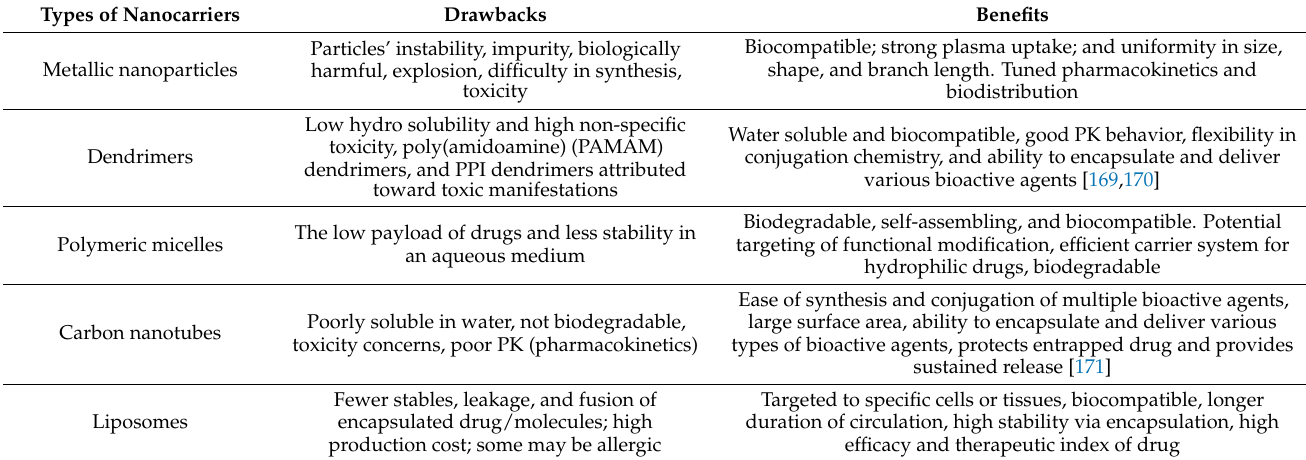
Table 3. Benefits and drawbacks of the various kinds of